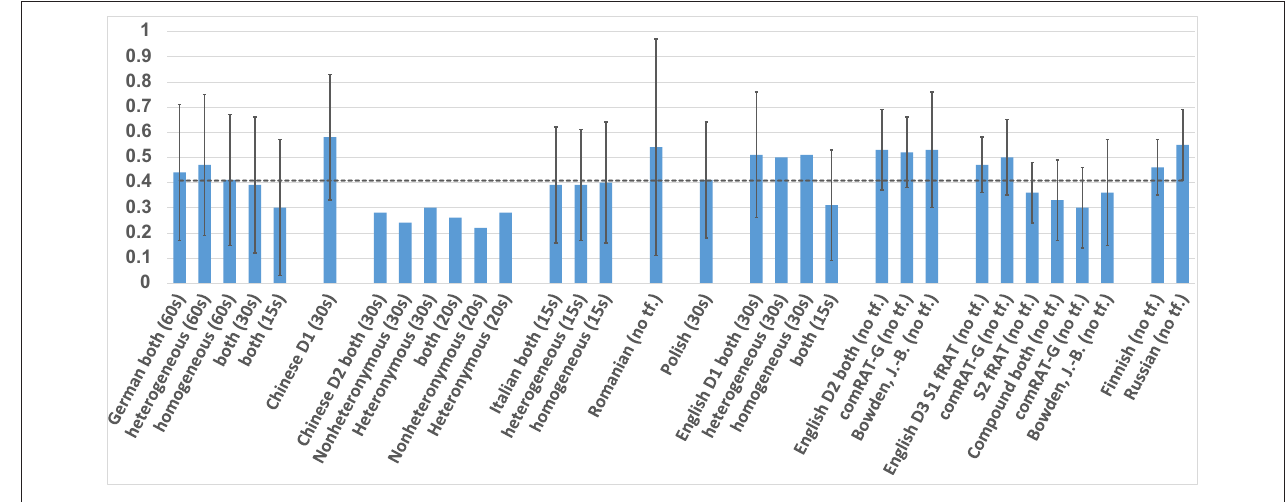
FIGURE 1 | Mean and SD Accuracy of RAT datasets in the different languages.